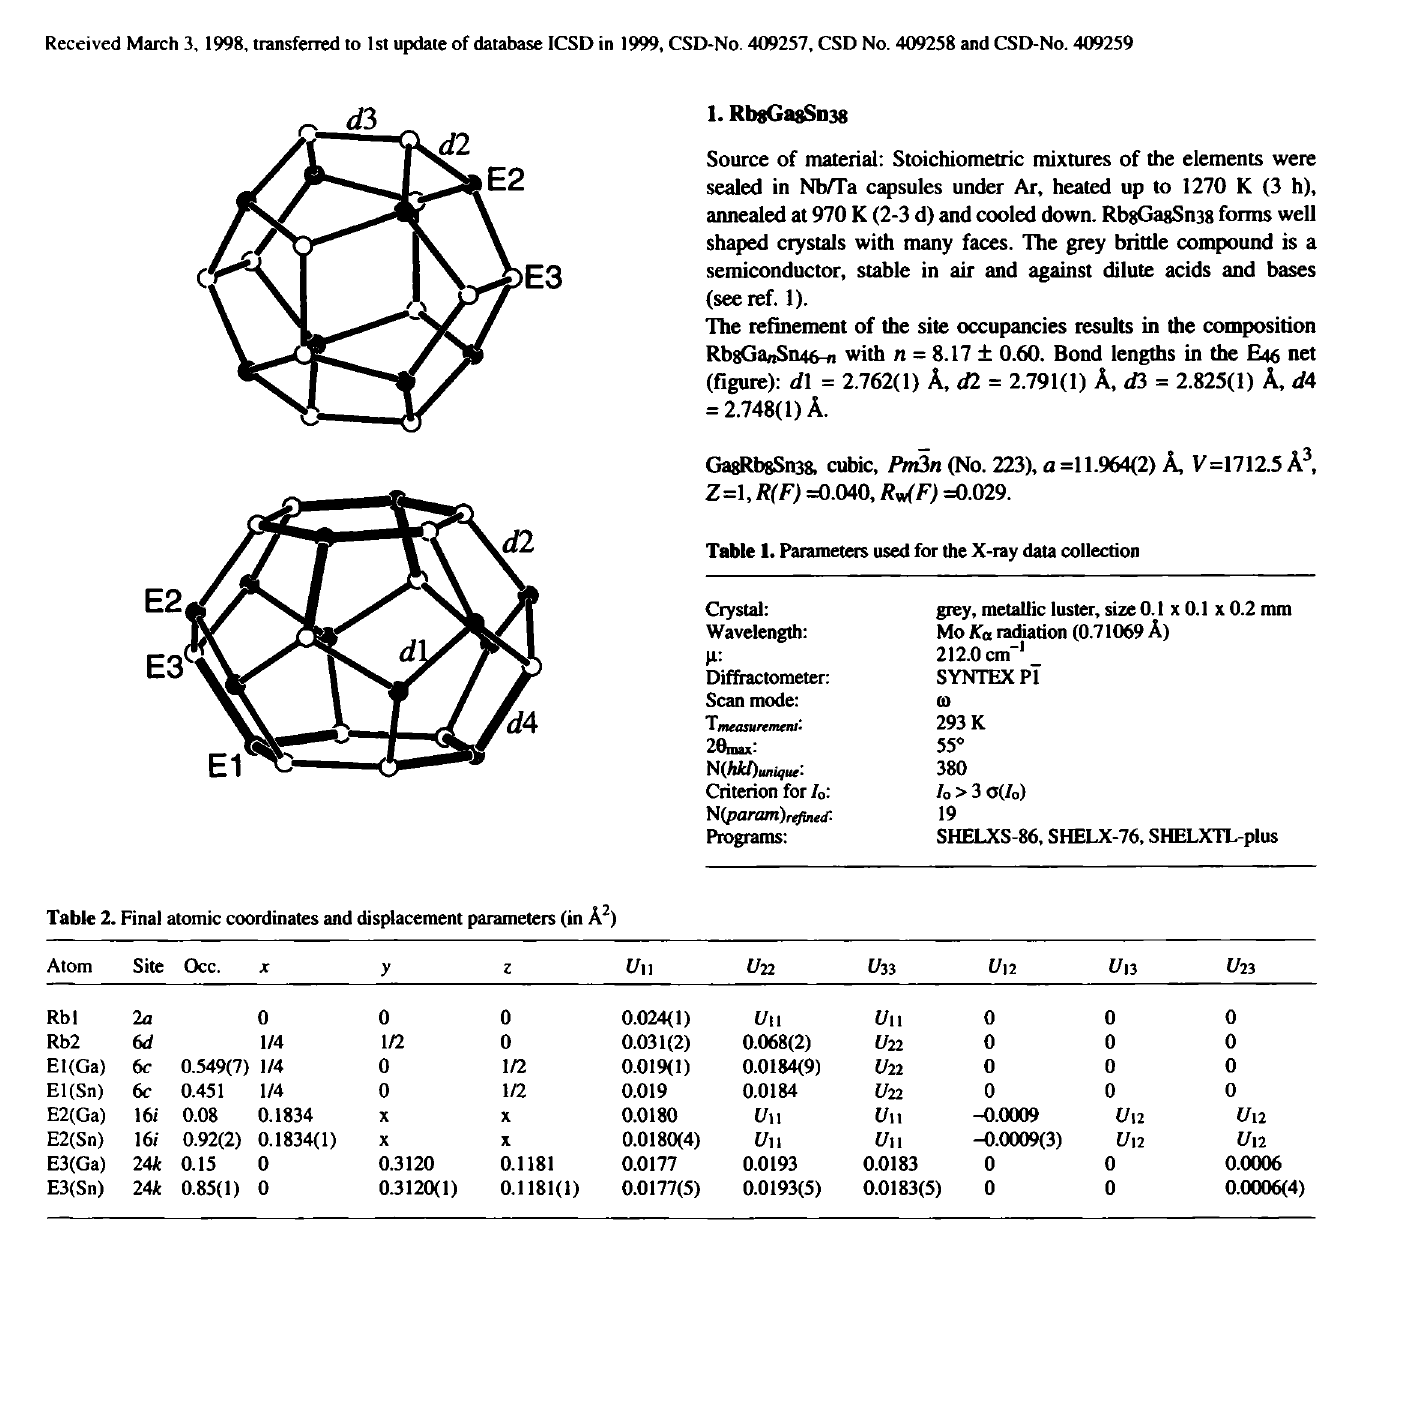
Table 1. Parameters used for the X-ray data collection Crystal: